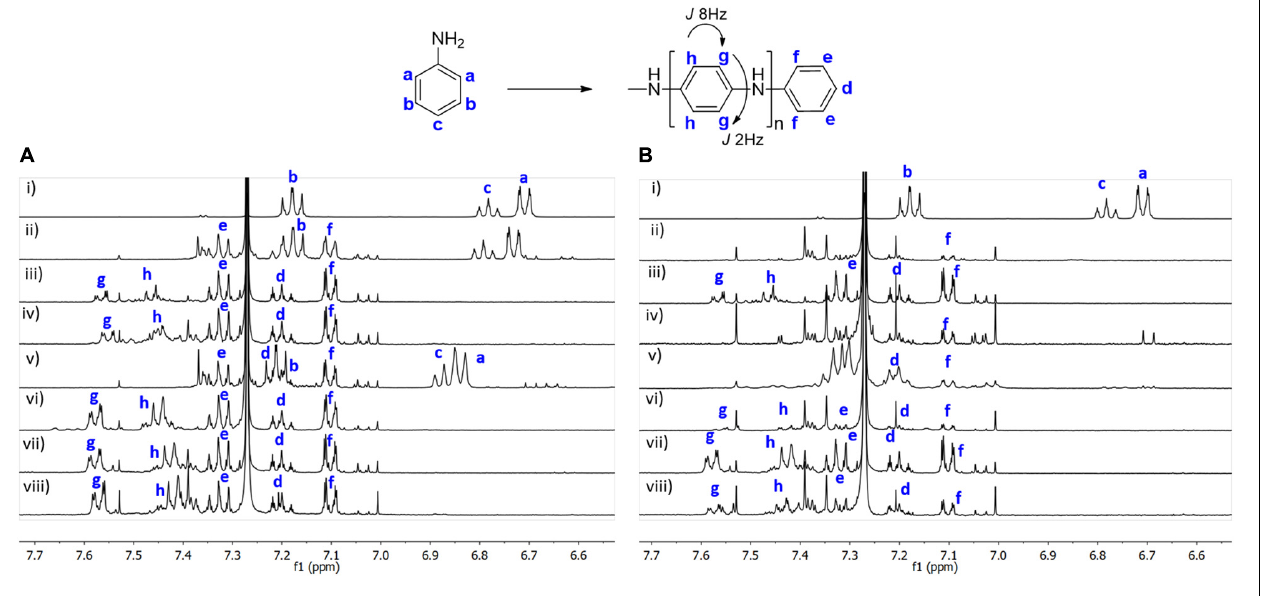
FIGURE 3 | 1 H NMR of polyaniline obtained after in situ reaction on BC under different conditions in the absence (A) and in the presence of CMC (B) . (A) : (i) aniline; (ii) aniline + laccase; (iii) aniline + KHCF; (iv) aniline + KHCF + laccase; (v) aniline + AOT; (vi) aniline + AOT + laccase; (vii) aniline + KHCF + AOT; (viii) aniline + KHCF + AOT + laccase; (B) : (i) aniline + CMC; (ii) aniline + laccase + CMC; (iii) aniline + KHCF + CMC; (iv) aniline + KHCF + laccase + CMC; (v) aniline + AOT + CMC; (vi) aniline + AOT + laccase + CMC; (vii) aniline + KHCF + AOT + CMC; (viii) aniline + KHCF + AOT + laccase +